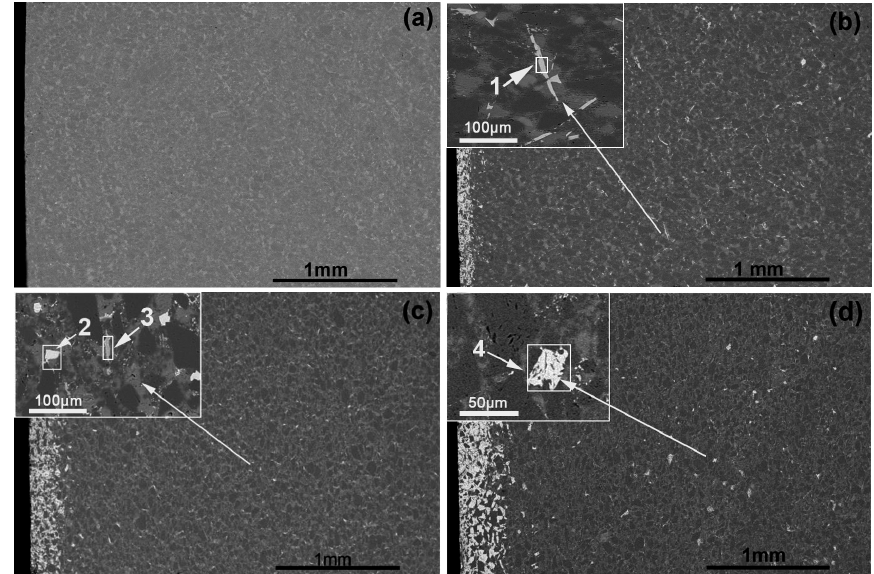
Figure 3. Low-magnification cross-sectional BSE images of the reaction layers and inner regions of the composites infiltrated by the Al–Si–xTi alloy (Si: 10 wt.%) with Ti contents (wt.%) of ( a ) 0, ( b ) 5, ( c ) 10, and ( d ) 15. Table 3. EDS analysis results of different inner regions shown in Figure 3.